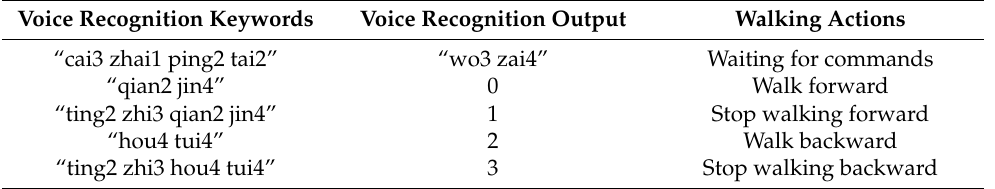
Table 7. Walking voice system control keywords.